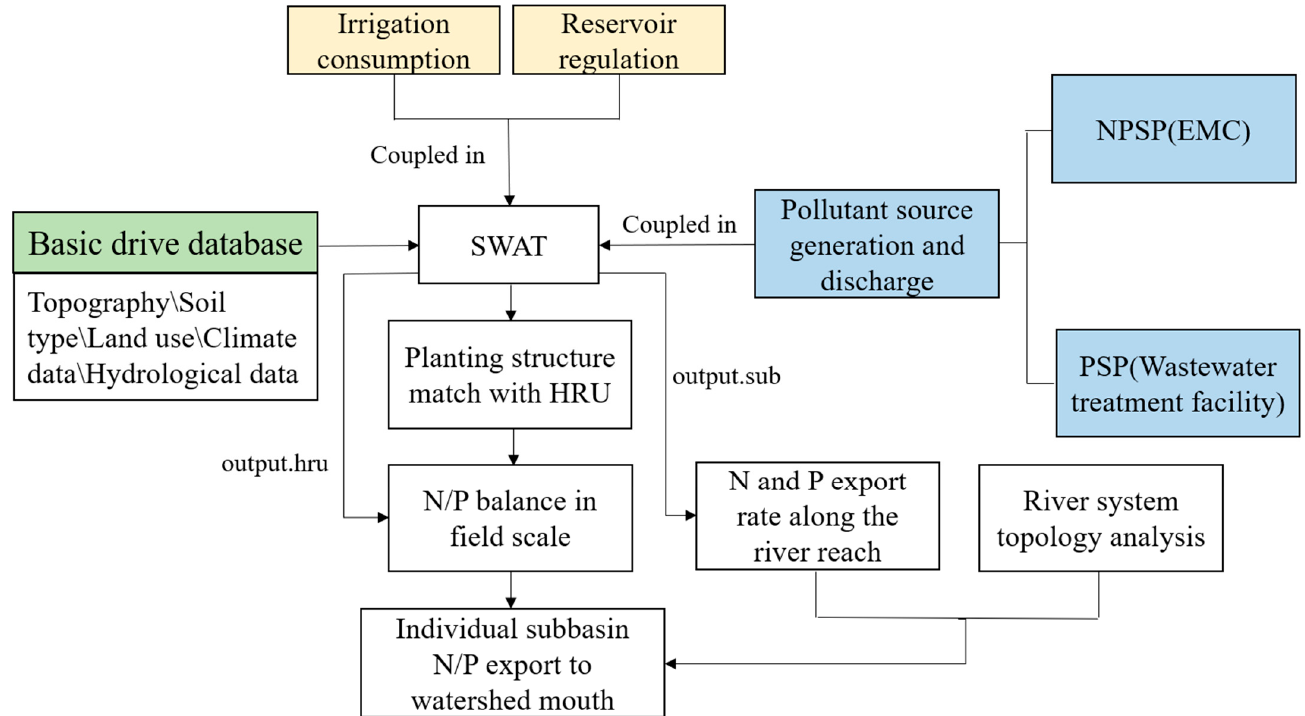
Figure 2. The overall workflow of the setting up of SWAT and its application in NELB.